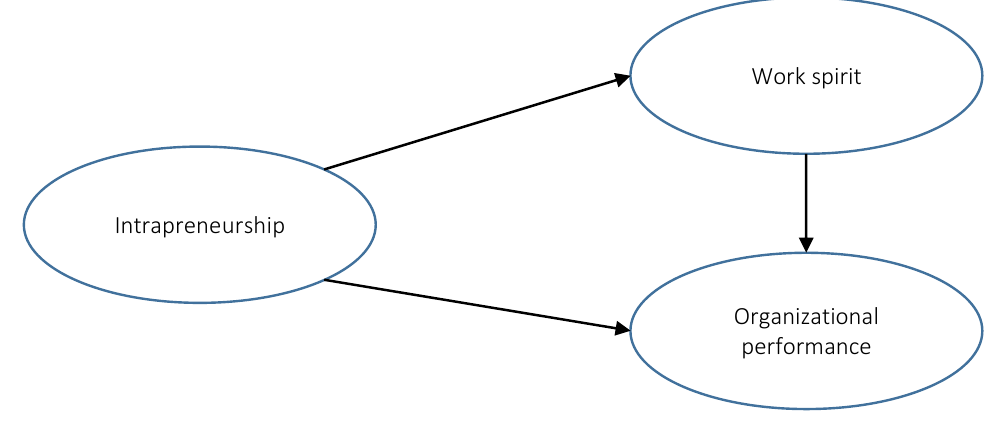
Figure 1. Concept framework of the relationship between intrapreneurship, works spirit, and